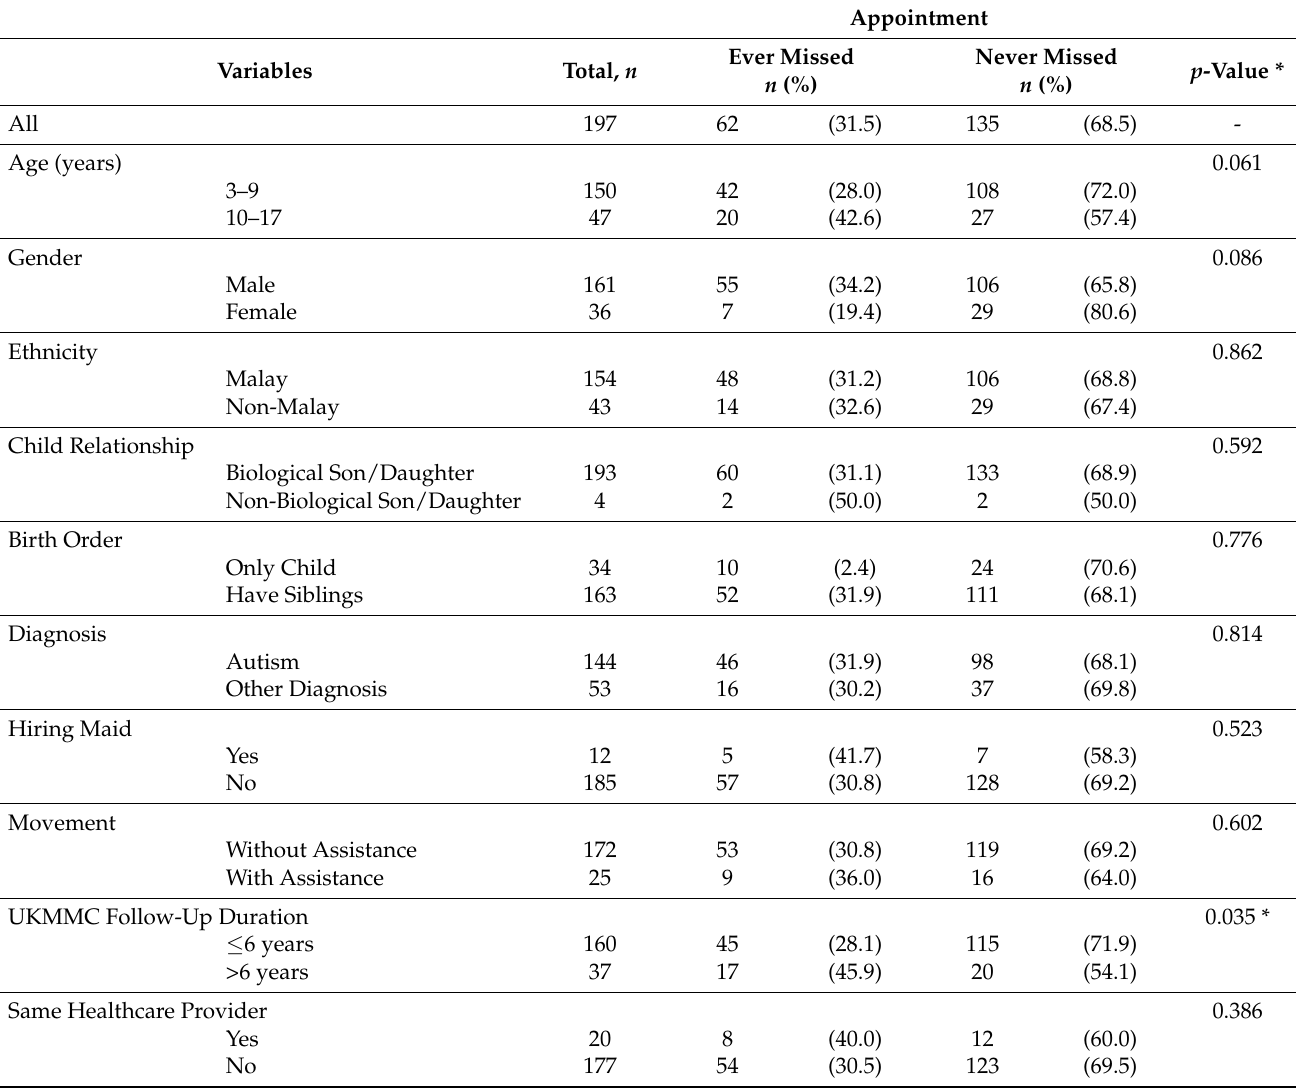
Table 6. Differences in missed appointment rates by sociodemographic and characteristics of children with developmental disabilities in the study ( n = 197).